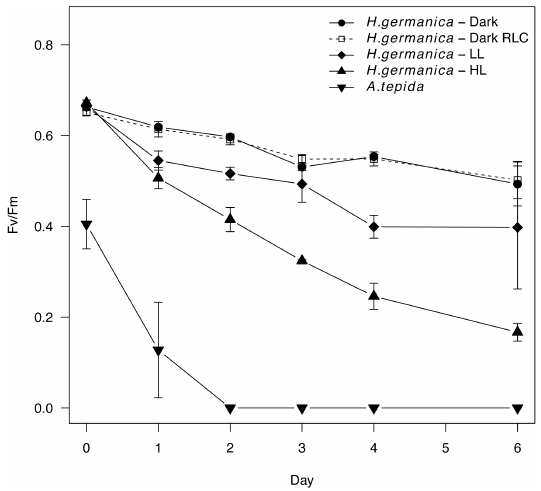
Figure 7. Maximum quantum efficiency of the photosystem II (Fv/Fm, n = 3) during the experiment for the different applied con- ditions (Dark, Low Light and High Light) and species ( Haynesina germanica and Ammonia tepida